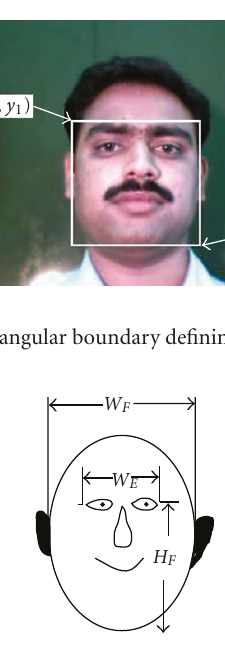
Figure 3: A sketch of face to define feature ratios.